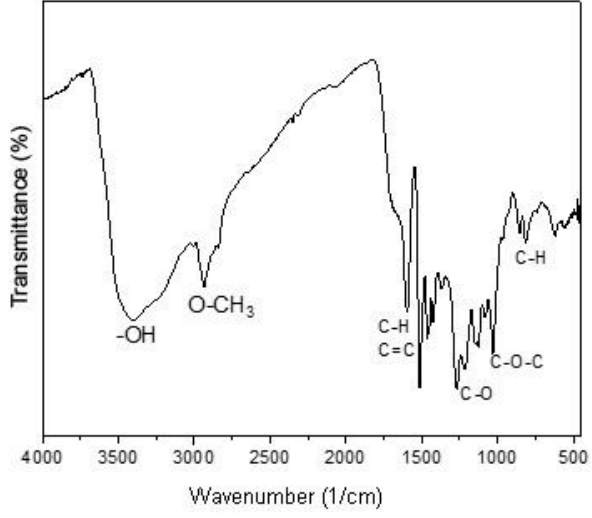
Figure 3. Kraft lignin IR spectrum.